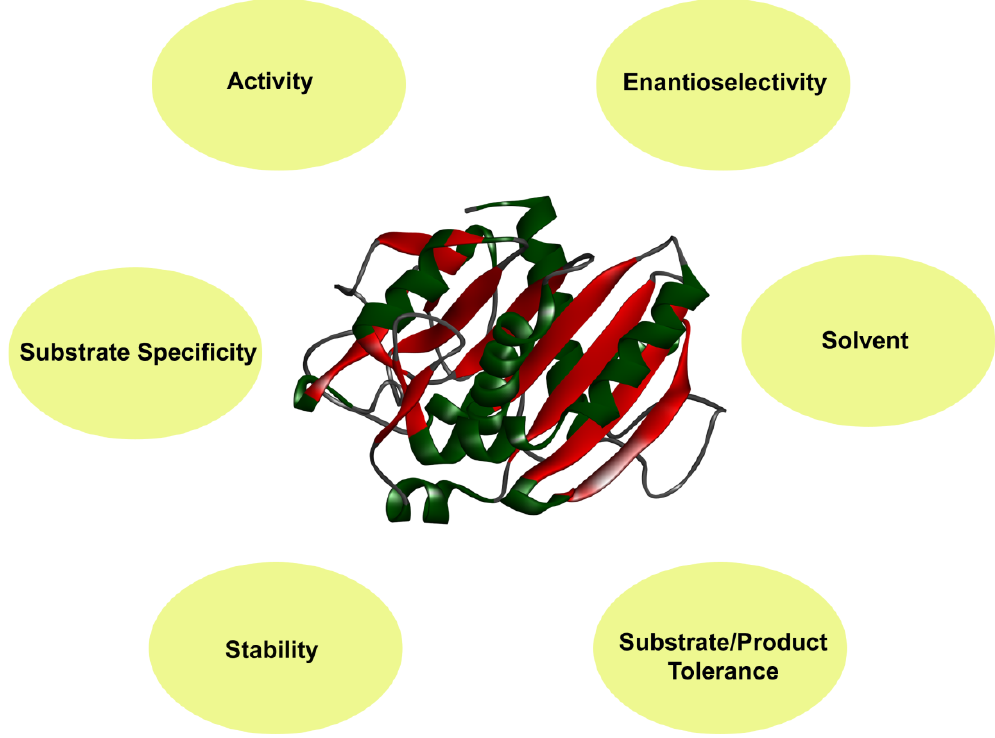
Figure 1. Evolvable enzyme properties for its successful utilization in industrial